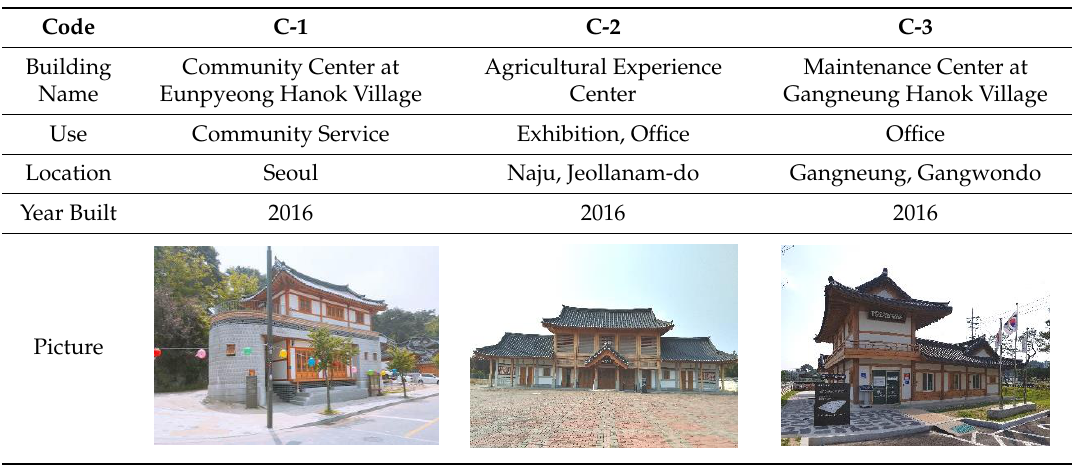
Table 4. Public Hanok facilities in Type C.